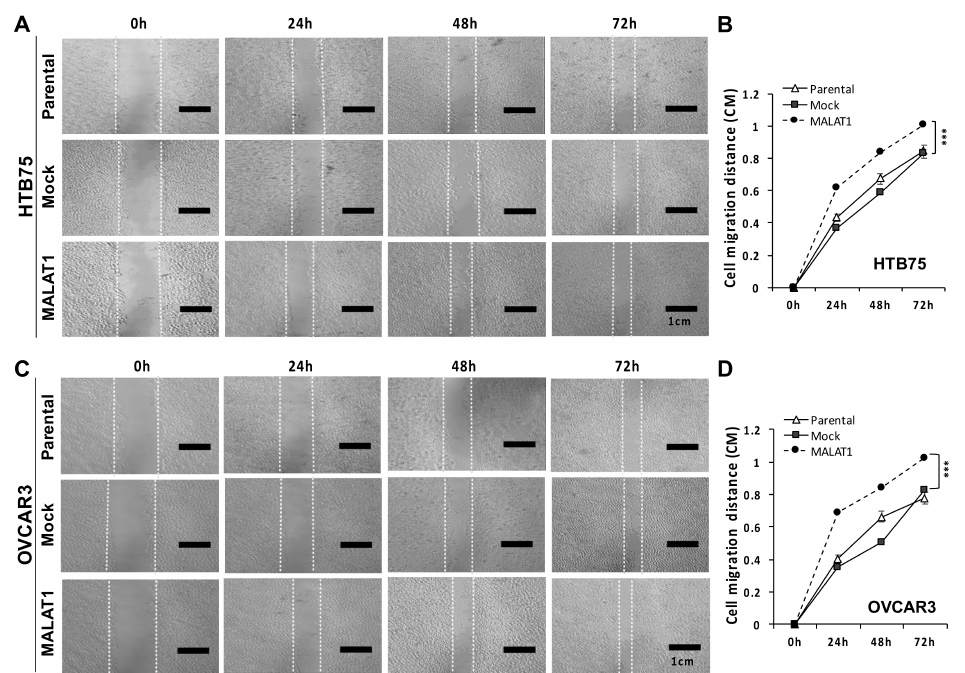
Figure 3. Overexpression of MALAT1 enhanced HTB75 and OVCAR3 cell migration: Representative images of cell migration and their relative migration distances in ( A , B ) HTB75 and ( C , D ) OVCAR3 cell lines following transduced overexpression of MALAT1. Both MALAT1-overexpressing HTB75 and OVCAR3 cells showed significantly increased migration distances after a wound scratch at 24, 48, and 72 h compared to the mock-transduced (Mock) and non-transduced (Parental) controls (*** p < 0.001). The scale bar is 1 cm. Representative experiments were repeated at least three times. In addition, we also investigated the role of MALAT1 overexpression in EOC progres- sion by transwell assays. Similar results were also obtained from the dramatic increases in cell invasion numbers, as shown in both HTB75 (*** p < 0.001; Figure 4A,B) and OVCAR3 cells (*** p < 0.001; Figure 4C,D). Invasive cells were counted following 12, 24, 36, and 48 h of incubation where MALAT1-transduced cells (MALAT1) showed significantly in- creased invasive cell numbers compared to their individual mock-transduced (Mock) and non-transduced parental cells (Parental) controls by crystal violet staining, indicating that MALAT1 overexpression promoted tumor cell invasion in EOCs. Together, these results revealed that elevated MALAT1 levels promoted cell migratory and invasive capacities indicating enhancement of EOC